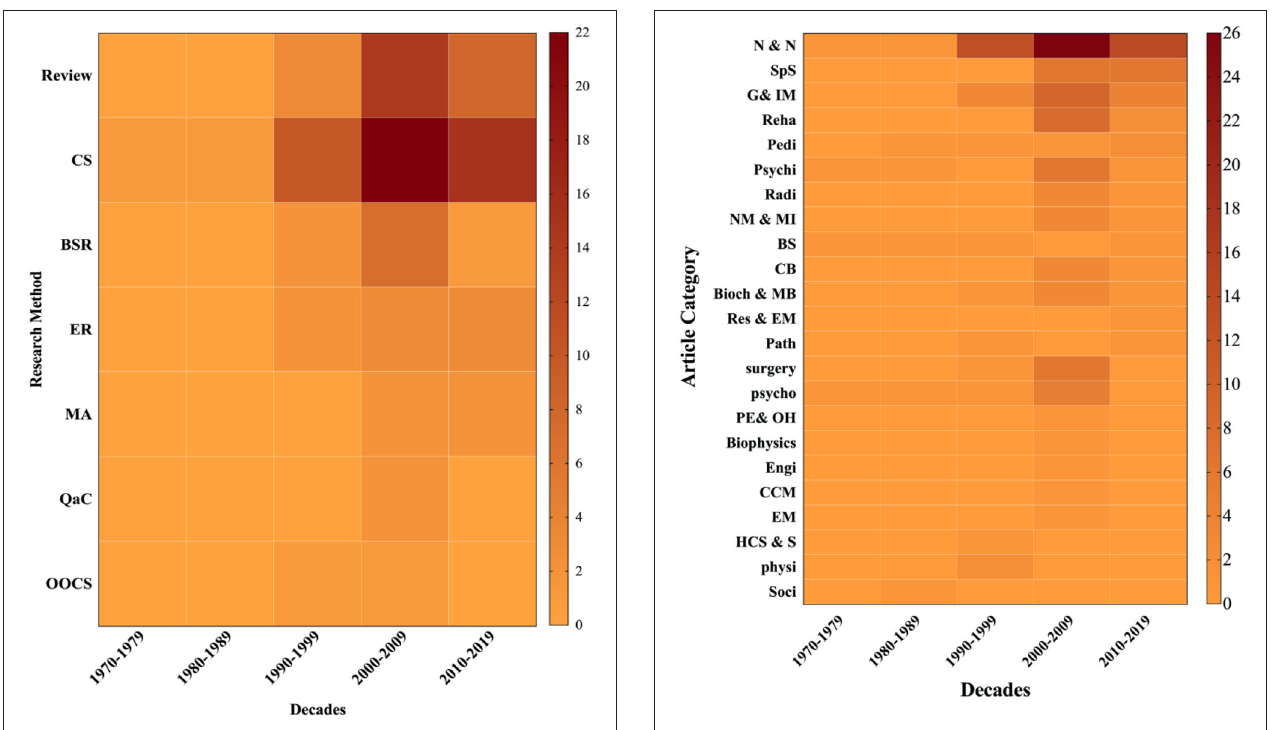
FIGURE 6 | Research methods vs. decades.